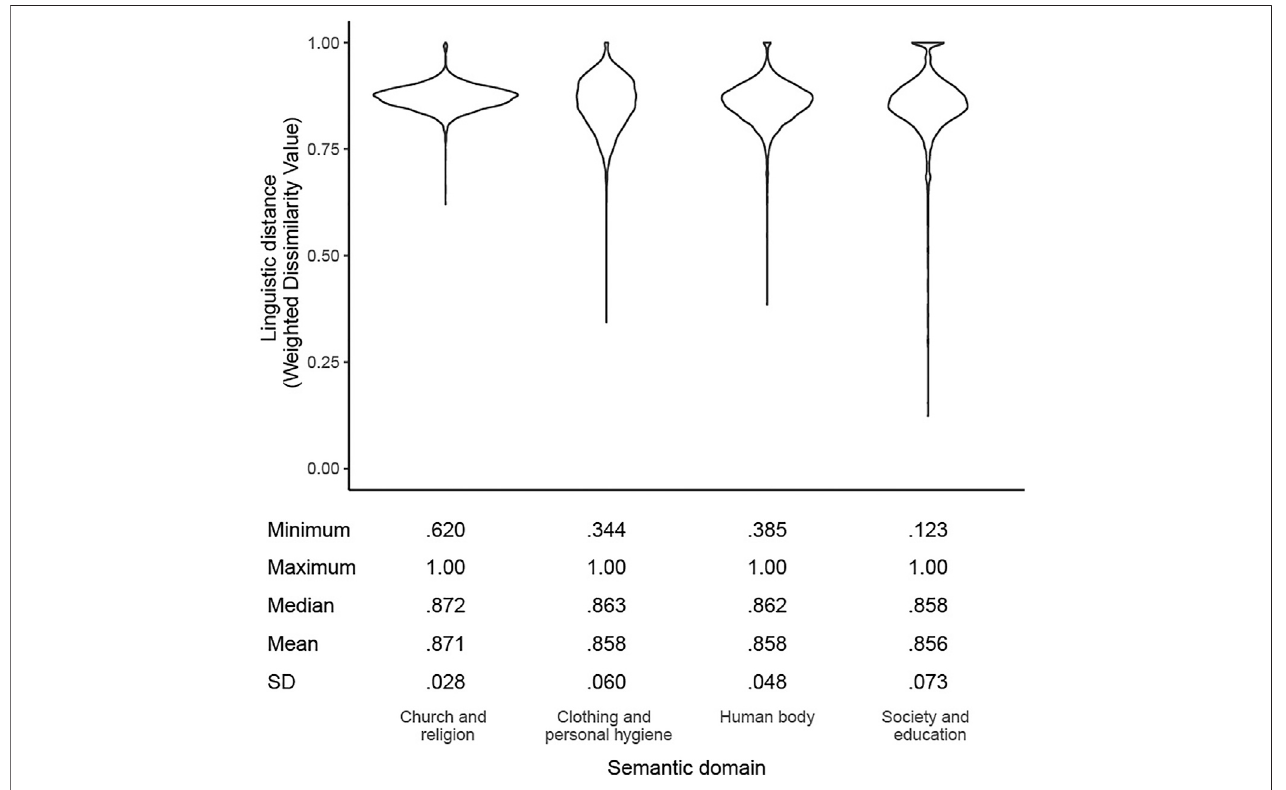
FIGURE 4 | Distribution of linguistic distances across four semantic